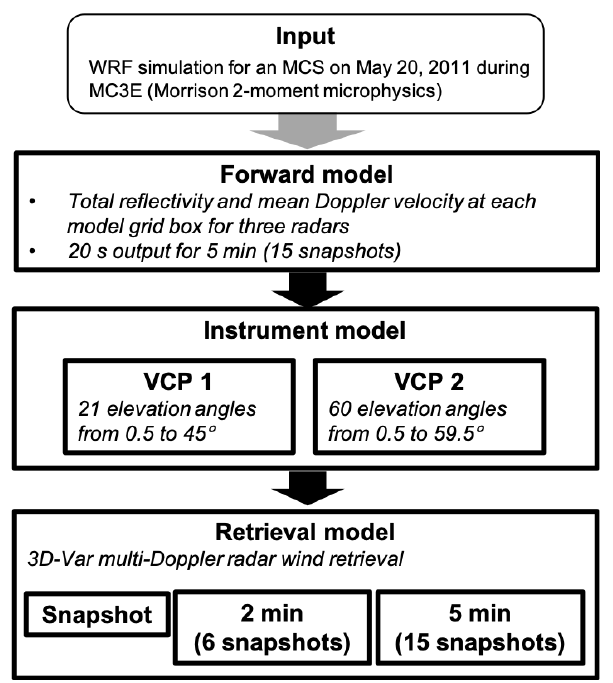
Figure 9. A diagram of an Observing System Simulation Exper- iment study to investigate the impacts of radar volume coverage pattern (VCP) on a multi-Doppler radar wind retrieval. multi-Doppler radar wind retrieval algorithm developed by North et al. (2017) to estimate the 3D wind field for a do- main of 50km × 50km × 10km with horizontal and vertical grid spacings of 0.25